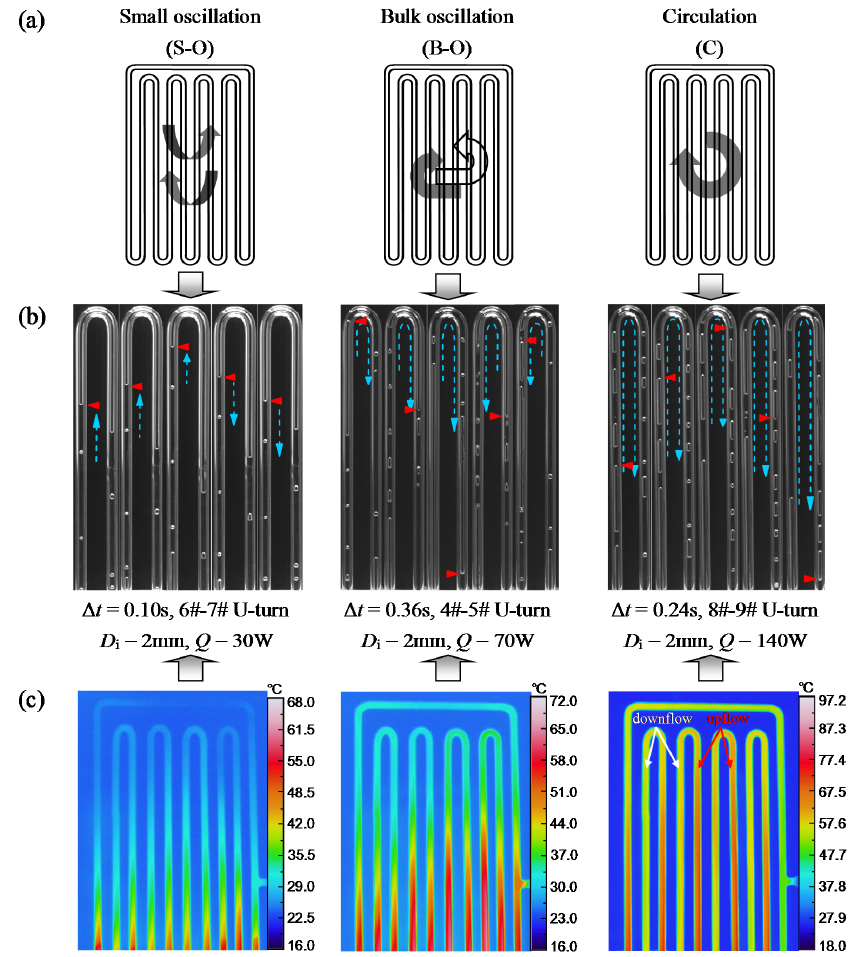
Figure 2. Fluid flow motions in the oscillating heat pipe (OHP) and corresponding experimental images as well as infrared thermal images of the condenser: ( a ) schematic of fluid flow motions; ( b ) snapshots of different fluid flow motions in a typical U-turn of condenser; and ( c ) infrared thermal images of the